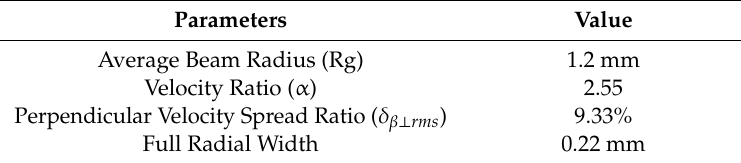
Table 6. Optimized beam parameters obtained by Magic 2D